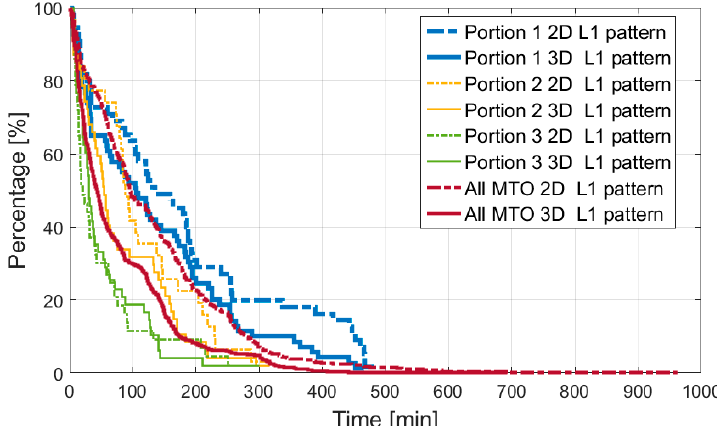
Table 3. Statistics for the number of available observations.